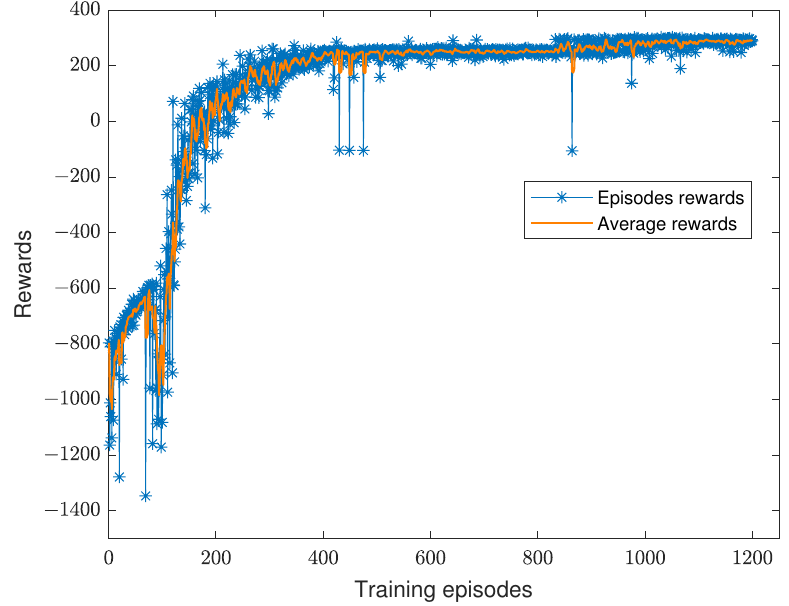
Figure 3. Convergence performance of the DQN-based data collection algorithm.